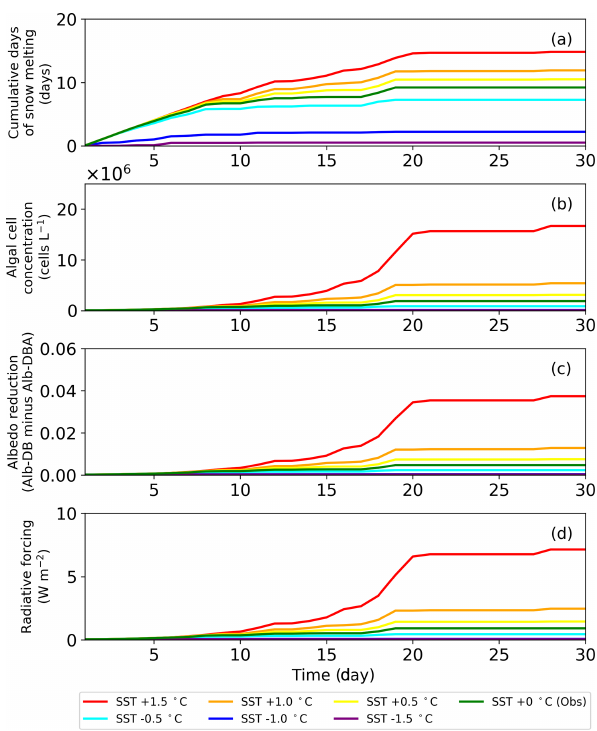
Figure 7. Temporal changes in (a) cumulative days of snow melt- ing (b) algal growth, (c) albedo reduction by snow algae and (d) ra- diative forcing by snow algae for 30d under various surface snow temperature (SST) conditions at the study